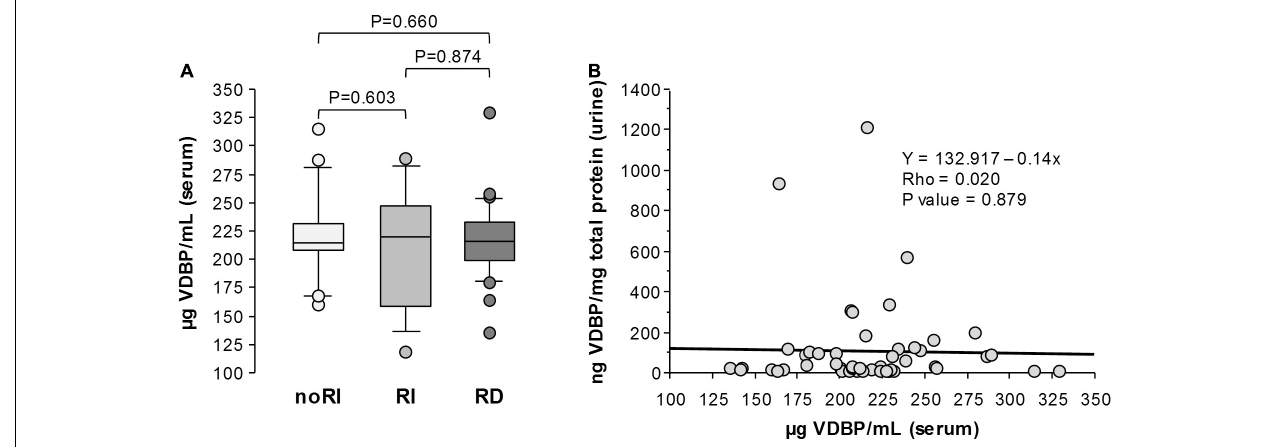
FIGURE 4 | Serum VDBP in patients with ADHF at day 3 of hospitalisation. (A) Box plot diagrams [median (IQR)] of VDBP levels quantified by ELISA in serum of patients with ADHF already presenting renal dysfunction at hospital admission (RD), developing renal function deterioration during hospitalisation (RI), and maintaining normal renal function (noRI). Groups’ comparisons were made by the Kruskal-Wallis and Mann-Whitney test. (B) Spearman correlation (Rho) between VDBP levels in serum and urine in patients with ADHF at day 3 of